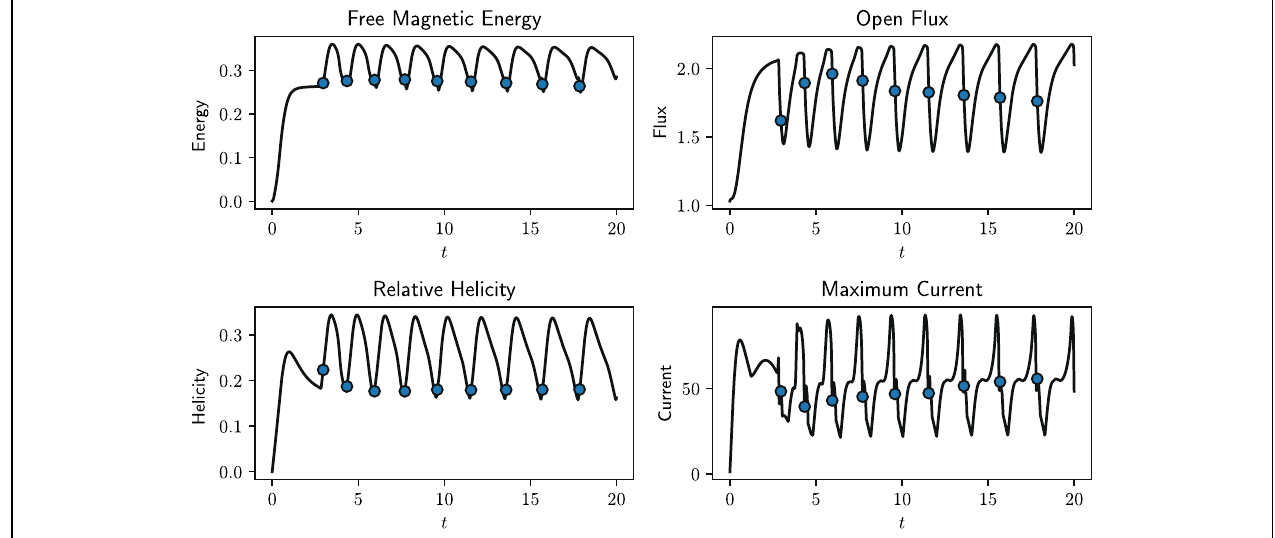
FIGURE 4 | A selection of diagnostics for a simulation exhibiting repeated arcade eruptions, which are represented by blue circles. In this simulation, η 0 = 0 and ν 0 = 0.5. The time of an eruption is taken to be the midpoint in time between the maximum and minimum open flux values either side of the eruption. there is no longer any flux contained within the rope after an eruption (although this is not always the case).